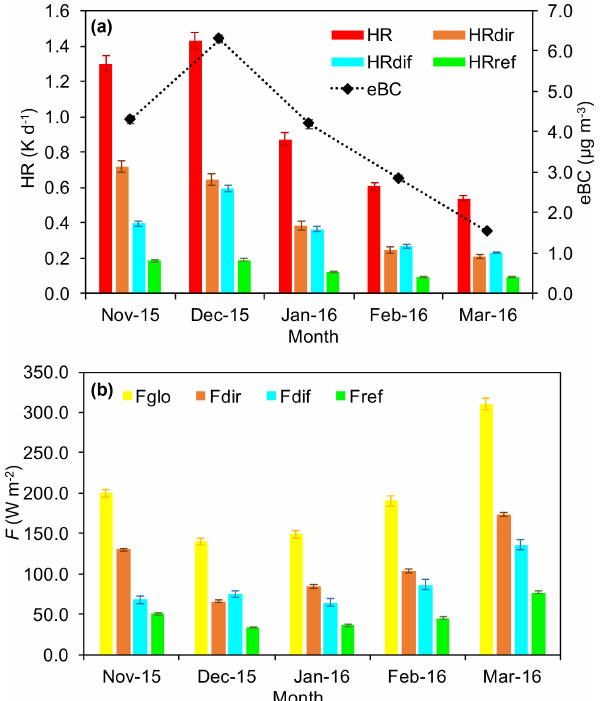
Figure 6. Monthly averaged values of (a) eBC and HR values and their direct, diffuse and reflected components (HR dir , HR dif and HR ref ); (b) global radiation values ( F glo ) and their direct, diffuse and reflected components ( F dir ,F dif and F ref ).